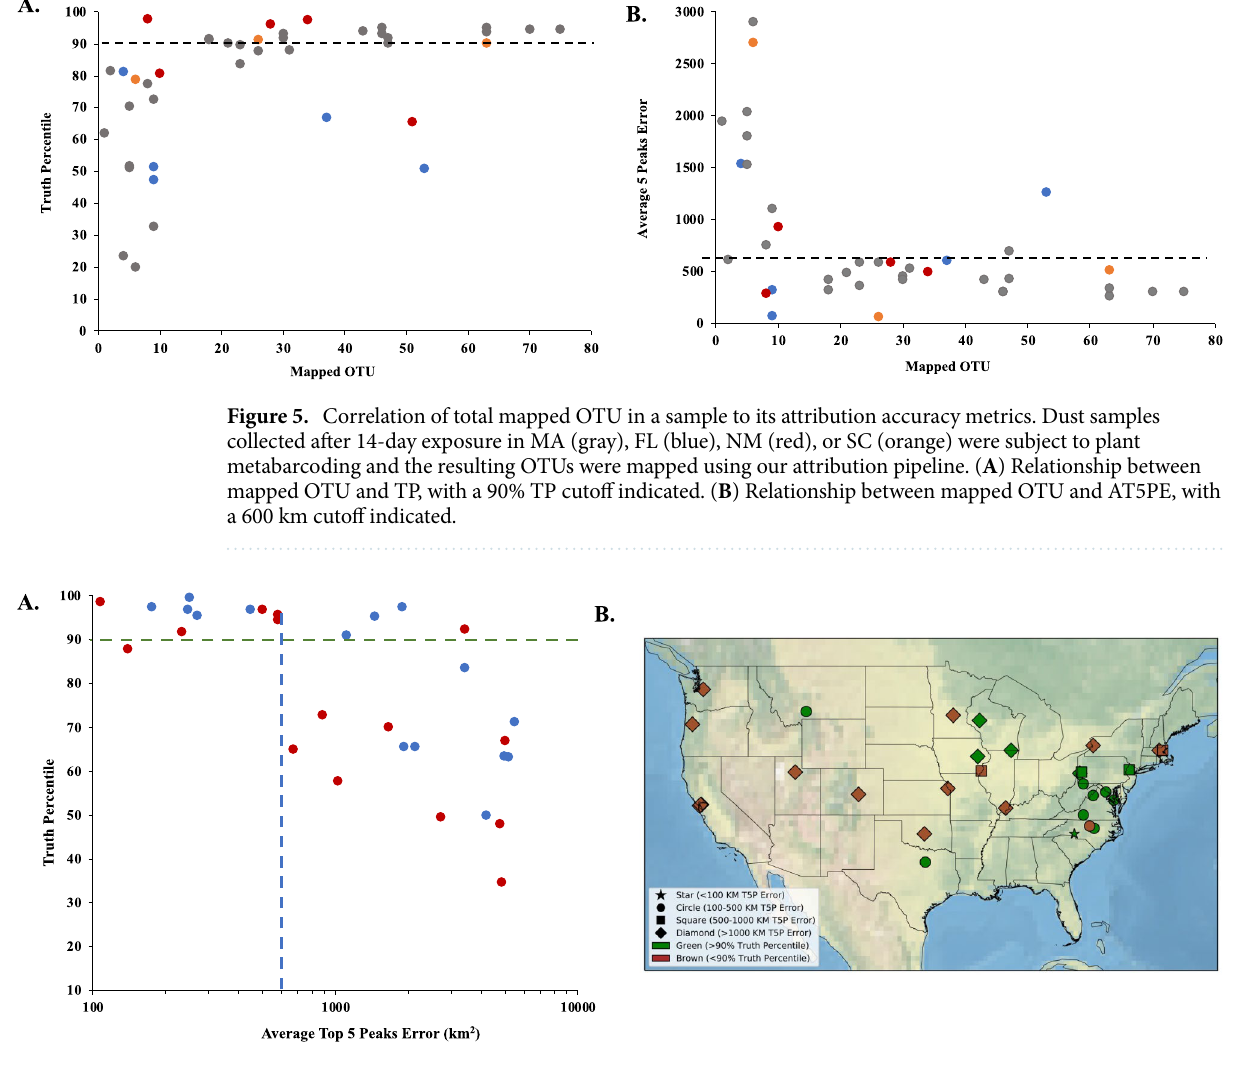
Figure 6. Attribution achieved with plant eDNA derived from 31 WLOH dust samples. ( A ) Correlation of TP to AT5PE in WLOH dust samples in samples with 20 or more (blue) or less than 20 (red) mapped OTUs. Cutoffs for 90% TP and 600 km AT5PE are shown. ( B ) Map of the site of sample collection of the 31 WLOH samples in addition to the attribution accuracy (TP) and resolution (AT5PE) determined from assessment of plant eDNA from dust samples. The color indicates a TP of greater (green) or less than (brown) 90%. The shape of the marker indicates AT5PE of < 100 km (star), 100–500 km (circle), 500–1000 km (square), or > 1000 km (diamond). Maps were generated using python packages interacting with ArcGIS v10.4, as described in